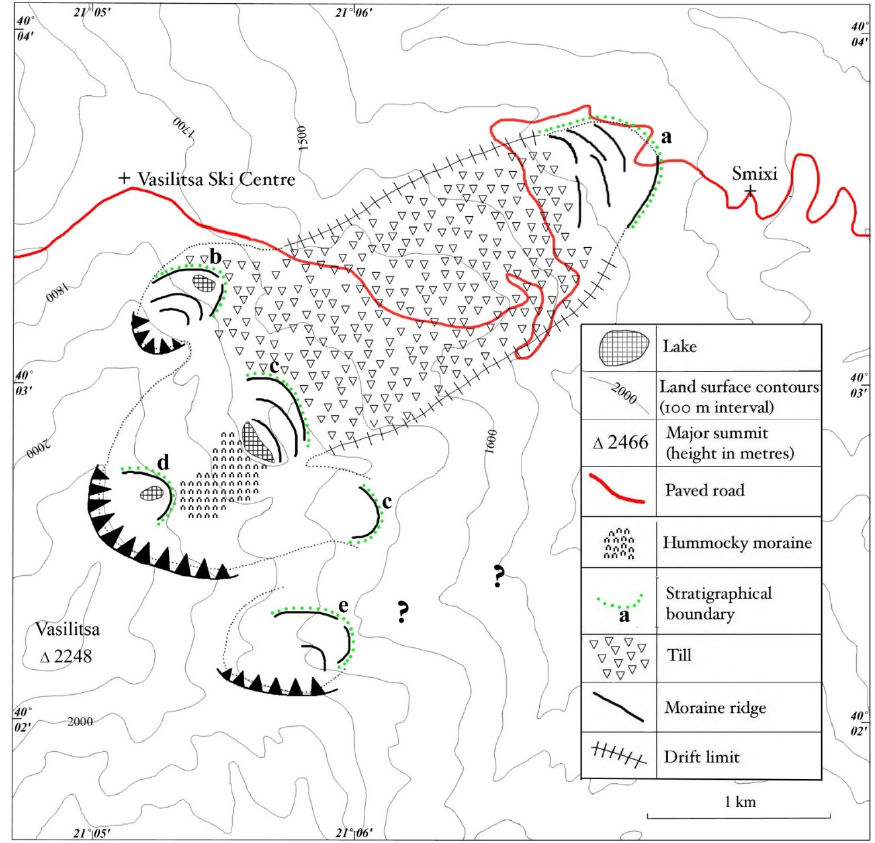
Figure 13. Geomorphological map of the Mount Vasilitsa area. The stratigraphical units marked ( a – d ) represent the Vasilitsa Formation: ( a ) Smixi Member, ( b ) North Vasilitsa Member, ( c ) Central Vasilitsa Member, ( d ) Vasilitsa Summit Member. The stratigraphic unit marked ( e ) represents the East Vasilitsa Member, the sole unit of the East Vasilitsa Formation (drawing by P. Hughes). Land 2023 , 12 , x FOR PEER REVIEW Further up-valley, moraine ridges impound a small lake on the north-eastern slopes at ca. 40°03 ′ 16 ″ N, 21°05 ′ 23 ″ E, 1750 m a.s.l. Two more ridges are present to the south-west of the lake. These sediments and landforms are named the North Vasilitsa Member and are interpreted as end and recessional moraine ridges formed in front of a former cirque glacier. Moraine ridges also exist further south and impound a lake at ca. 40°02 ′ 52 ″ N, 21°05 ′ 40 ″ E, 1790 m a.s.l. (Figure 14). Here, at least three moraine ridge crests can be de- fined. These landforms are identified as the Central Vasilitsa Member. Hummocky, boul- der-covered moraines are present up-valley of these ridges and probably formed during glacier retreat. A boulder ridge is also evident in the shallow valley to the southeast at ca. 1730 m a.s.l. and appears to represent the terminus of an off-shoot glacier which had the same source as the glacier which produced the lake moraines described above.